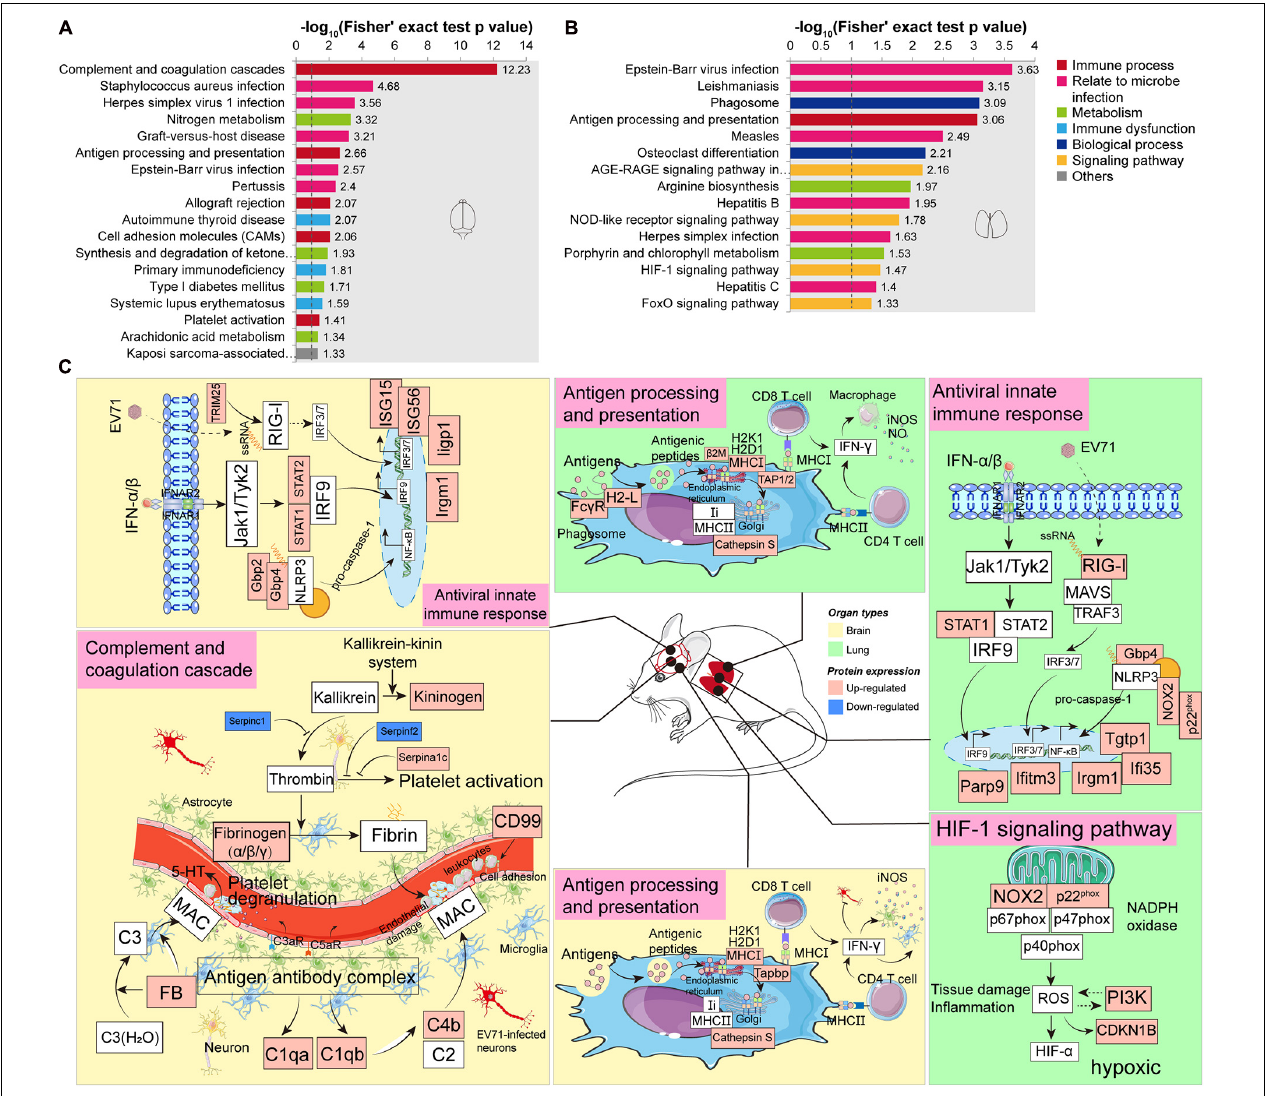
FIGURE 4 | Kyoto Encyclopedia of Genes and Genomes (KEGG) enrichment analysis of significantly dysregulated proteins. (A) KEGG enrichment analysis of significantly dysregulated proteins in the brain. (B) KEGG enrichment analysis of significantly dysregulated proteins in the lung. (C) A hypothetical systems view of the two organs’ responses to EV71 infection. In the brain or lung, the virus and its released RNA could induce an antiviral innate immune response. APCs bind antigens and internalize, process, and express them on their surface for recognition by certain lymphocytes such as CD4 T cells and CD8 T cells. In the brain, the virus infection induces complement activation which contributes to disease by attracting and activating inflammatory cells and by direct damage to endothelial cells through MAC. The endothelial dysfunction leads to the activation of coagulation cascade and platelet through KKS cascade. In the lung, the NADPH oxidase activity was significantly increased in response to EV71 infection, which might activate the HIF-1 signaling pathway, leading to a hypoxic condition. Red boxes, upregulated proteins/pathways; blue boxes, downregulated proteins/pathways.